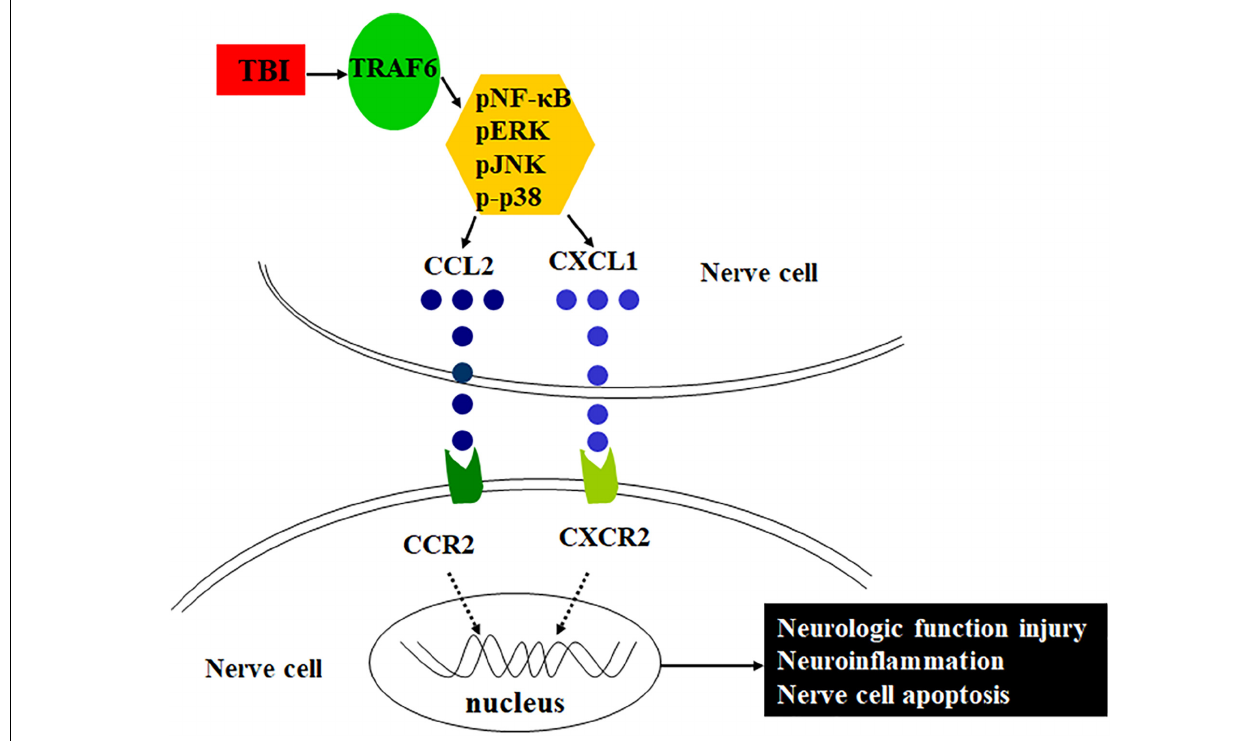
FIGURE 1 | Schematic of the possible mechanism of neuroinflammation following TBI. TRAF6 expression is upregulated after TBI, which activates downstream MAPKs or NF- κ B intracellular signaling pathways, induces the expression of chemokines CCL2 and CXCL1, and acts on the corresponding receptors CCR2